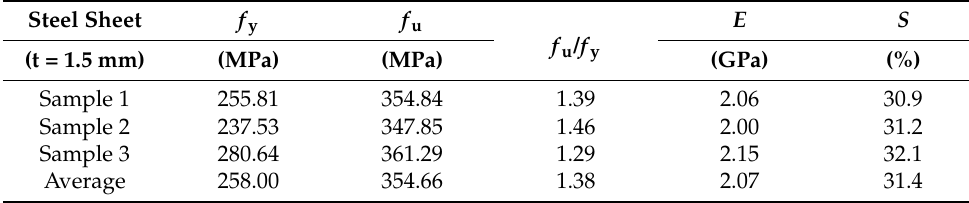
Figure 8. Stress–strain curves of the 1.5 mm steel sheet. Table 3. Test results of material properties for the 1.5 mm steel sheets.